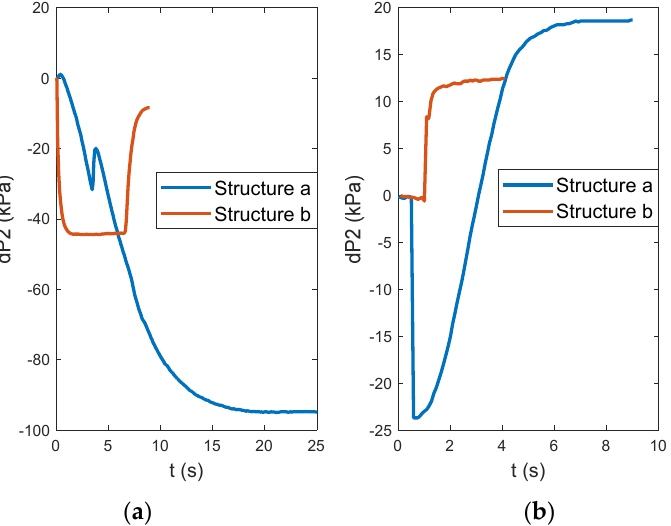
Figure 12. Pressure fluctuation during the transit-switching process of the dual-ejector system: ( a ) pressure fluctuation when switching from Ejector A to Ejector B; ( b ) pressure fluctuation during switching from Ejector B to Ejector A.